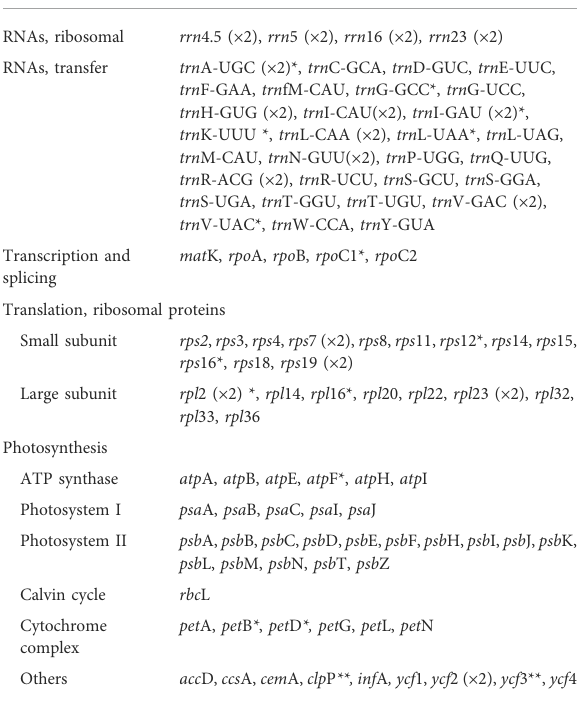
TABLE 2 Genes present in the plastid genomes of four species of Renanthera used in this study.